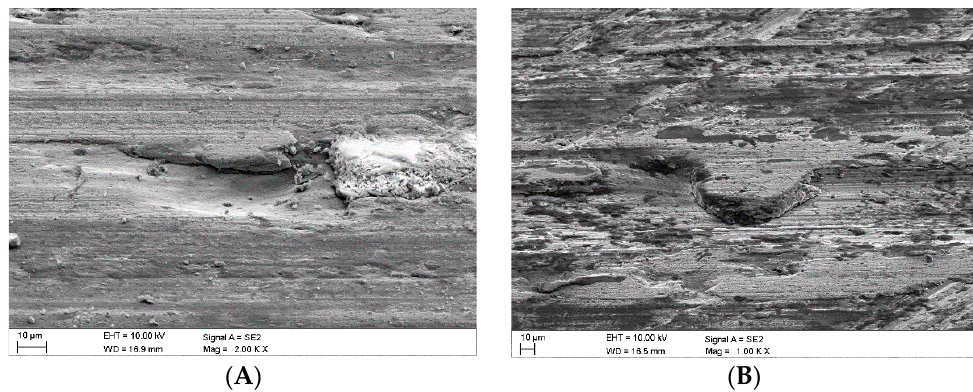
Figure 14. Images of the surface of the steel samples worn in the presence of the Claystone_3 abra- sive; ( A )—microscratches filled with crushed claystone grains, ( B )—scaly surface cracks against the background of the microscratches.